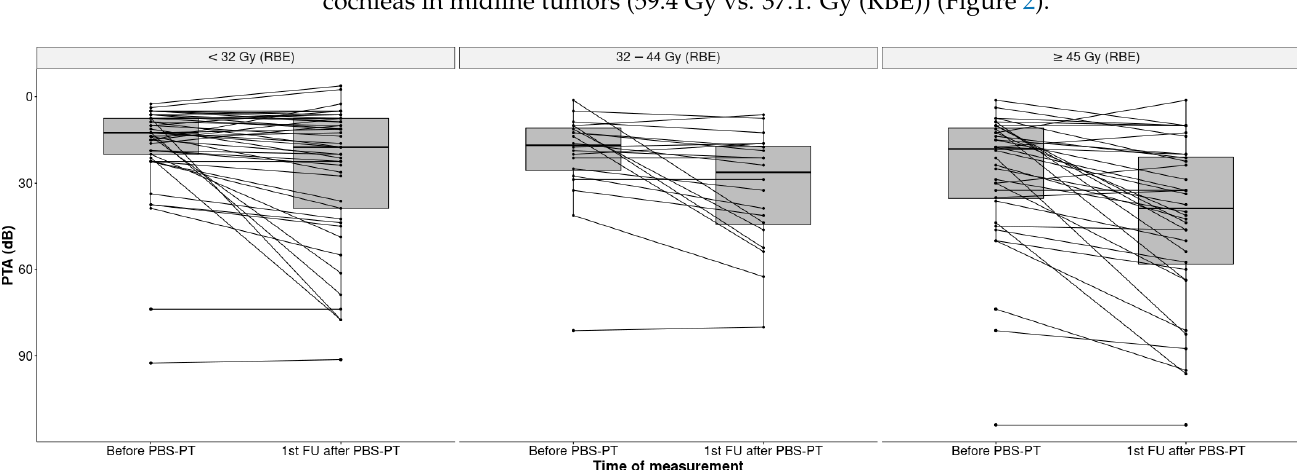
0.001). Additionally, the ipsilateral cochlear dose of lateralized tumors was higher than in both